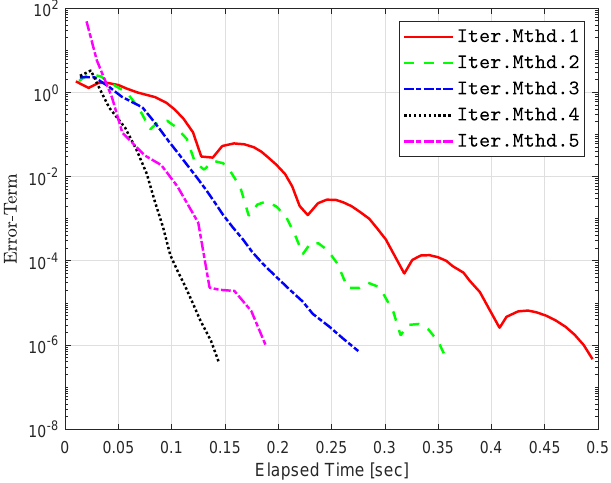
Figure 16. All techniques are computationally examined while s 0 = ( 6, − 1,5, − 4,1 ) T